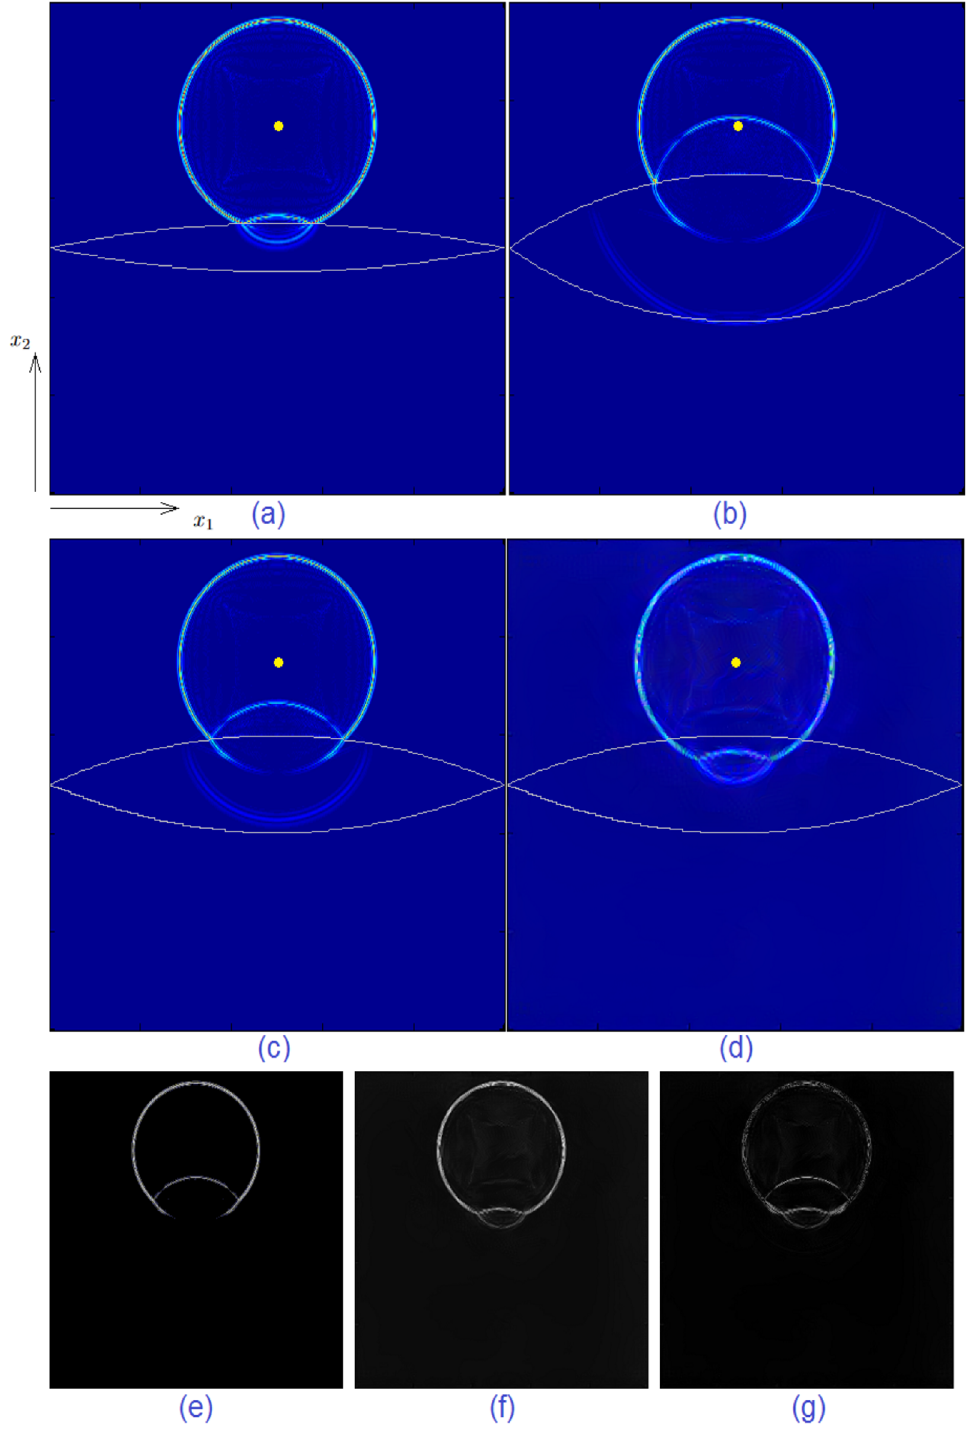
Fig. 6. Snapshot time t =140 m s for the radiation pattern of a point force (directed along x 2 ) generating a Ricker pulse with central frequency 250 kHz and spectral bandwidth 10 kHz, located at 12.5 cm from the top and 25cm from the left and the right edge of a fi eld of 50 cm by 50cm, applied to three cases. (a) the “ Lens 1 ” , (b) applied to the “ Lens 3 ” , (c) applied to the “ Lens 2 ” (c); (d) shows the neural style transfer result between (a) and (b), (e) is (c) transformed in a grayscale image, (f) is (d) transformed in a grayscale image and (g) is the absolute value of the difference between (e) and